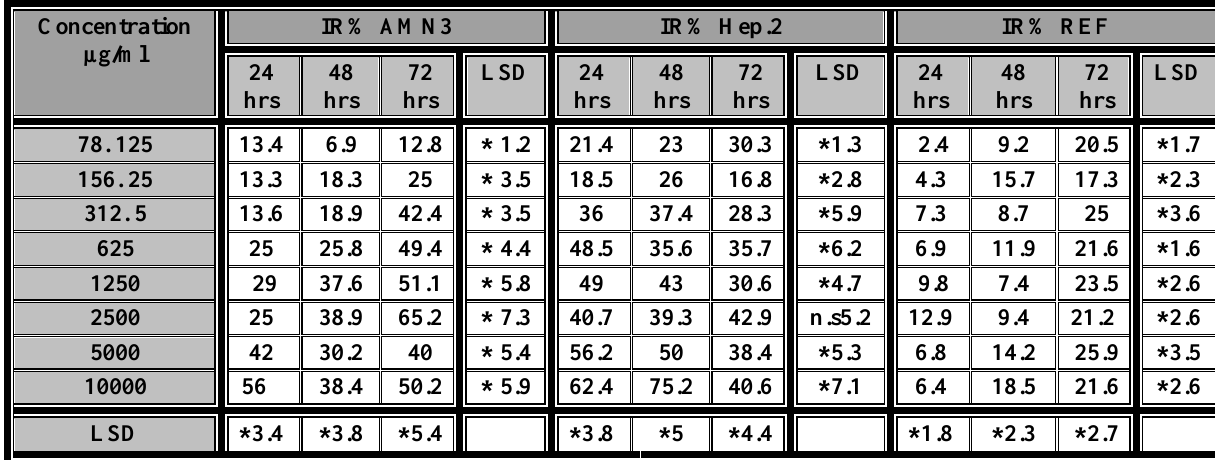
(*) Significant difference between means (comparison between columns and comparison with rows at levels (P<0.05). (n.s) Non-significant difference between